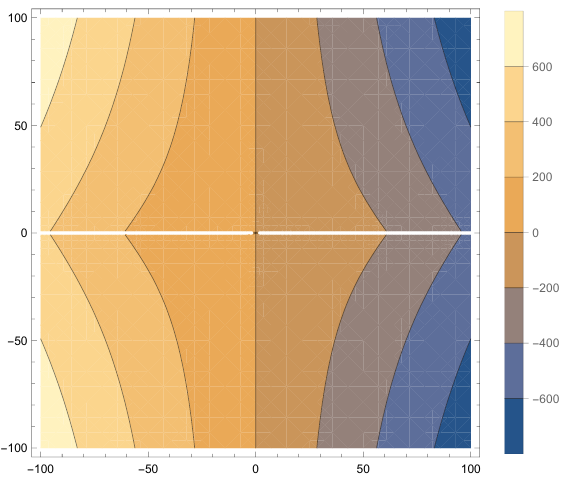
Figure 4 . Plot of the real part of F 0 ( (cid:21) ) on the complex (cid:21) -plane. integral representation